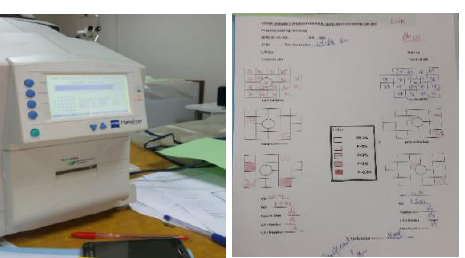
Figure 8. Various details of a test result are copied from the FDT screen to a paper form.